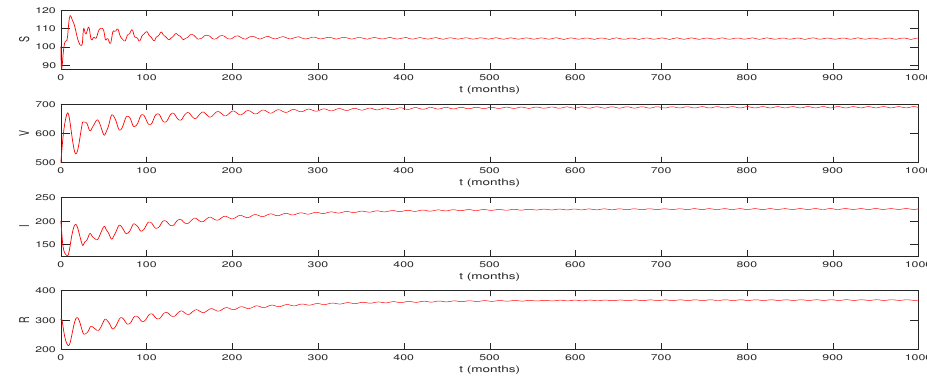
Figure 11. τ 2 ∗ = 25, τ 1 ∗ = 7, equilibrium E 2